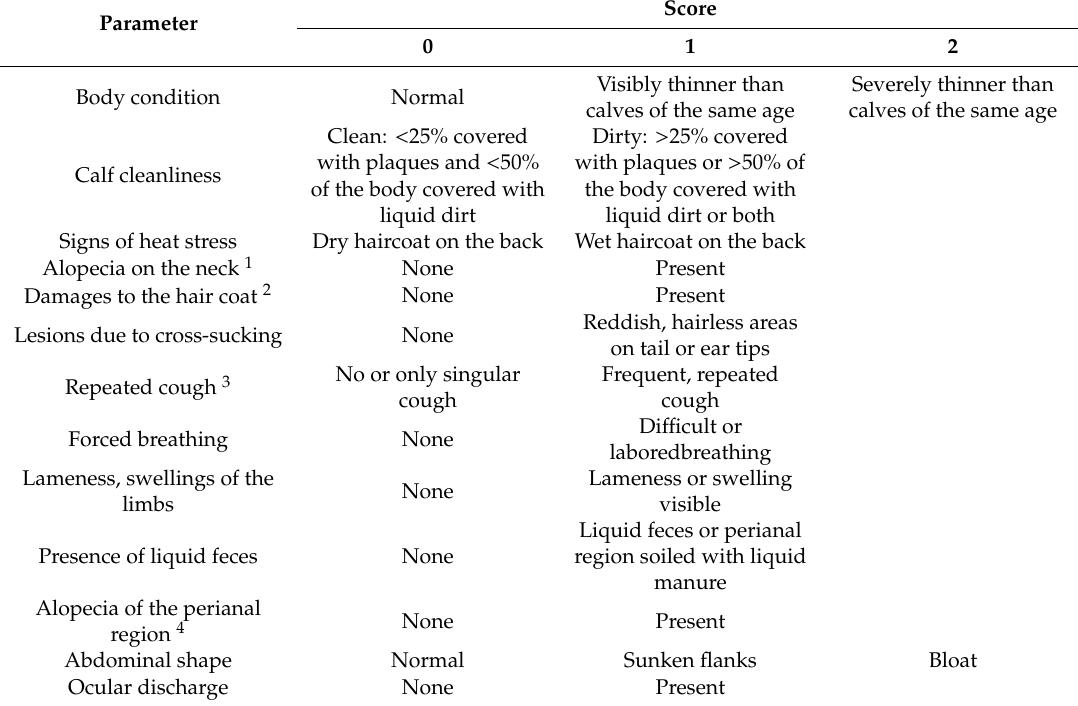
Table 3. Scoring system for individual calf examination at the last farm visit before